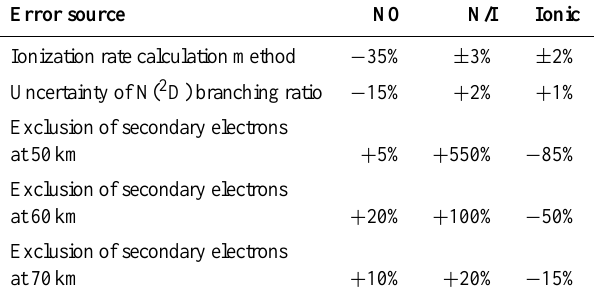
Table 8. The maximum error estimates for the values presented in Fig. 2 (NO, for nitric oxide), Fig. 3 (N/I, for the total num- ber), and Fig. 4 (Ionic, for the total number). The effect of uncer- tainty of N( 2 D) branching ratio was studied by changing the ratio